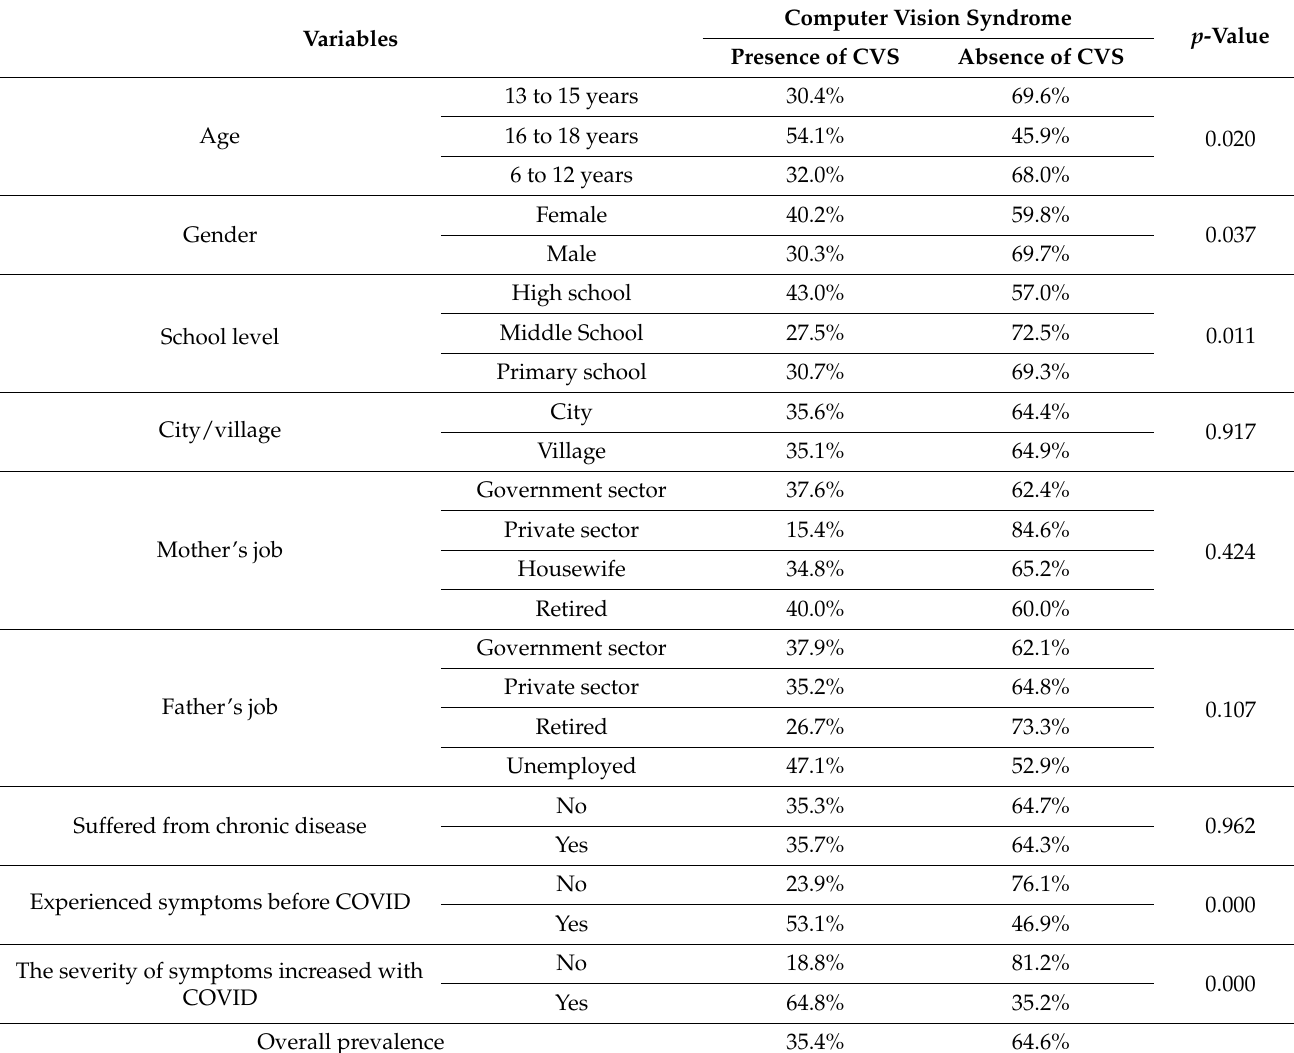
Table 2. Prevalence of CVS according to some selected